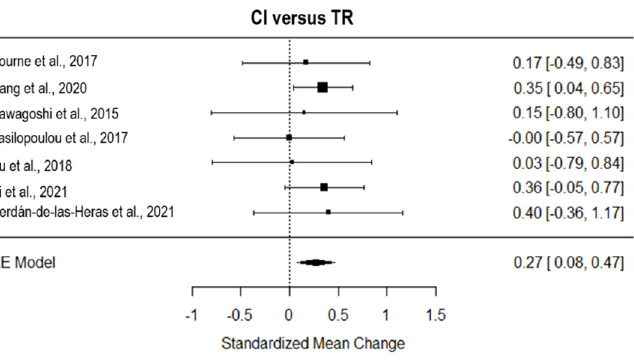
Figure 5. Forest plot of the effect of TR on dyspnea compared to conventional intervention. CI, conventional intervention; TR, TR [8,24–26,30,36,37].